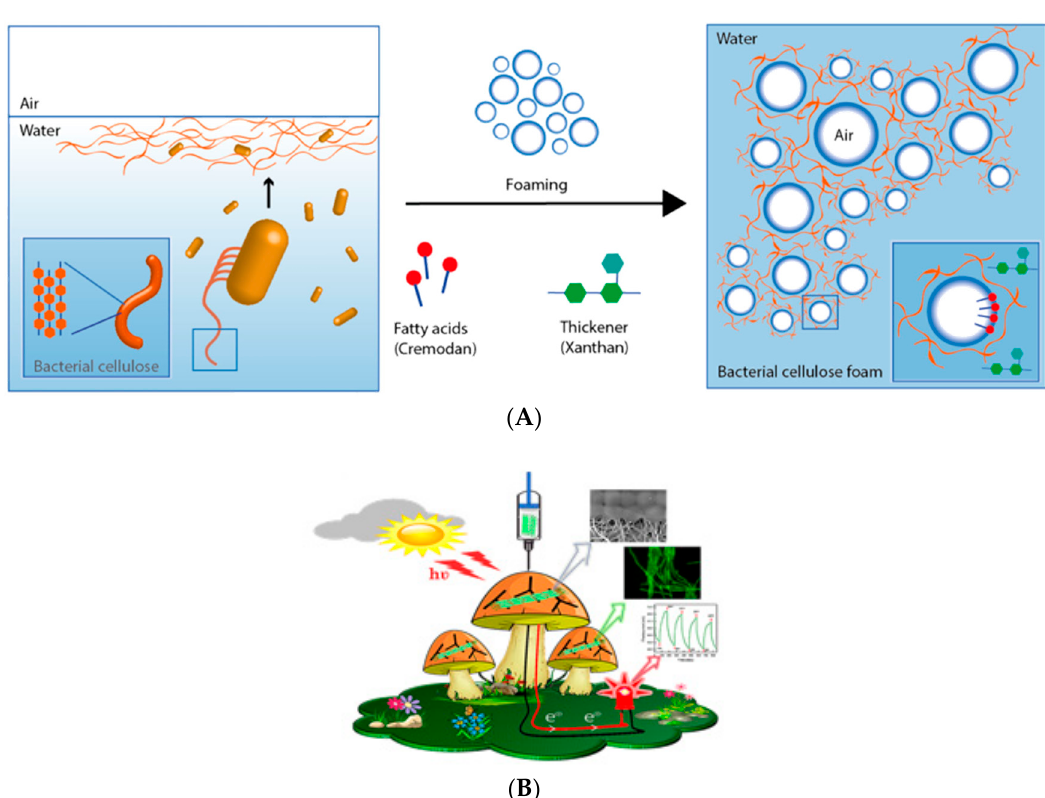
Figure 4. ( A ) Schematic of the formation of bacterial cellulose foam through foaming of a mannitol-based media with a bacterial suspension of Gluconoacetobacter xylinus. Cremodan as a surfactant stabilises the foam. Xanthan provides stability to the foam [11] (Open access). ( B ) Schematic drawing of mushrooms with 3D printed layer of cyanobacteria and graphene nanoribbons for the production of bioelectricity. Reprinted with permission from [12]. Copyright (2018) American Chemical Society.